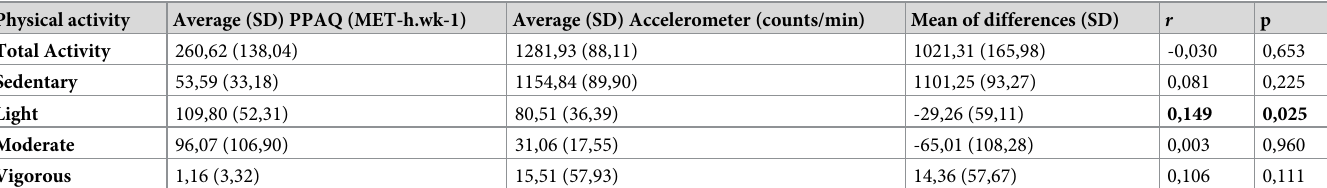
Table 6. PPAQ and accelerometer means and Pearson’s r correlation coefficient values between the PPAQ and the accelerometer (n = 226). Physical